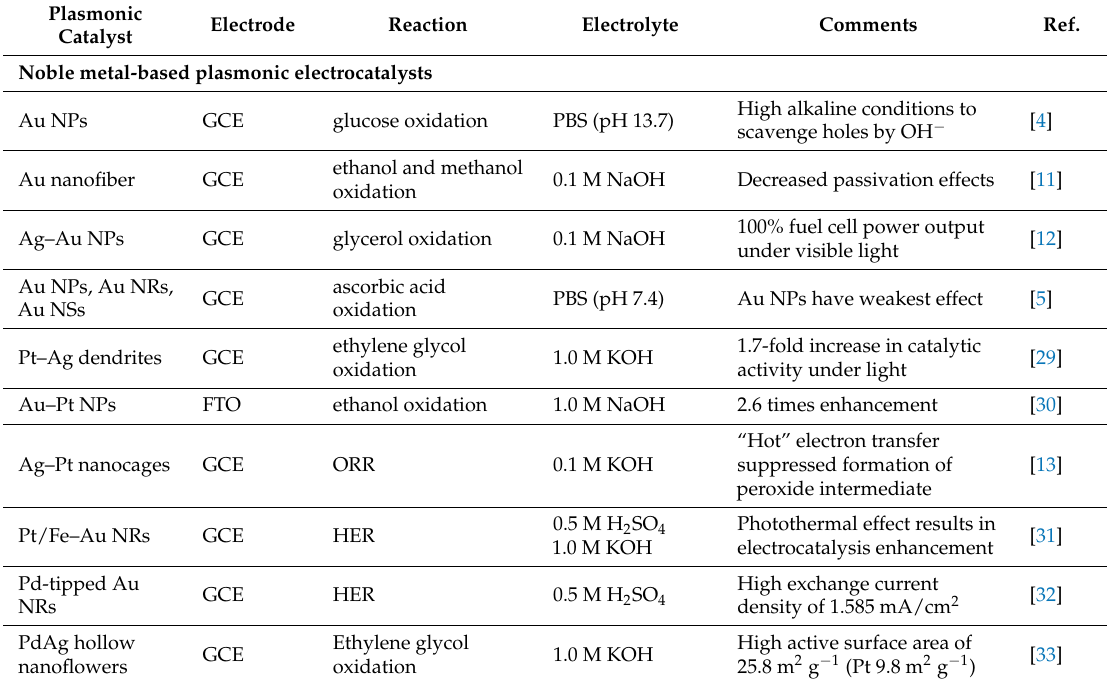
Table 1. Plasmon-mediated electrochemical catalysis.